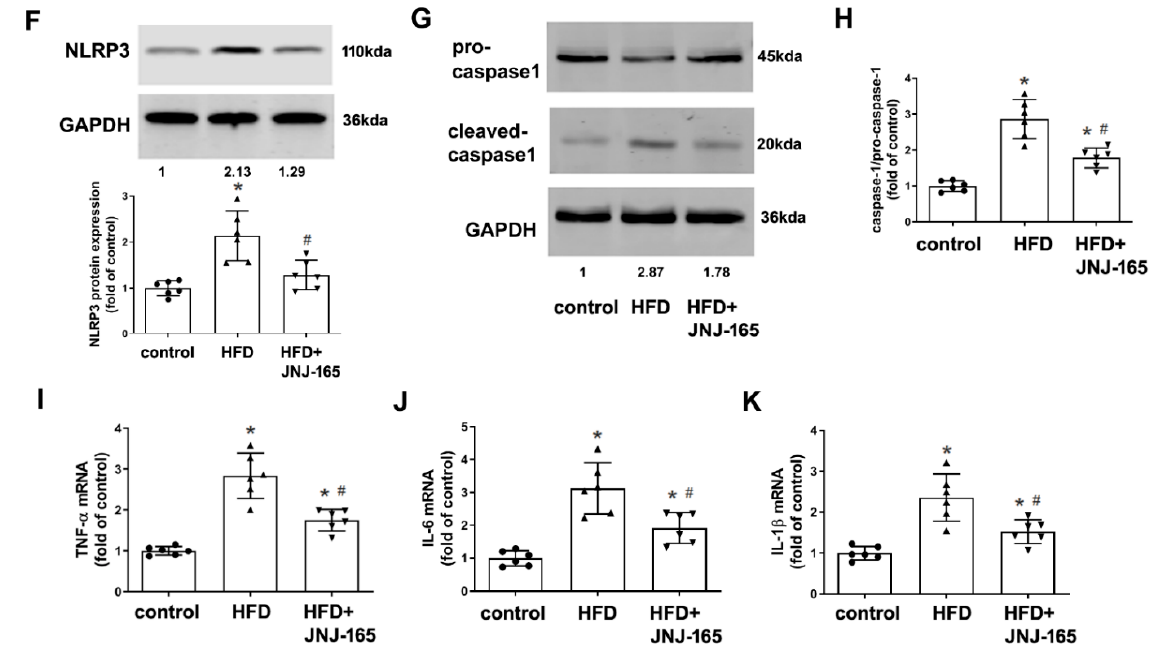
Figure 9. MDM2 inhibition alleviates mitochondrial damage and related inflammation in HFD-fed LDLr -/- mice. ( A , B ) Representative images and quantification of thoracic aorta cross-sections stained with mitoSOX Red. ( C ) The protein expression of PGC1 α . ( D ) The protein expression of TLR9. ( E ) NF- κ B p65 DNA binding activity. ( F ) The protein expression of NLRP3 in the aorta. ( G , H ) The protein expression of caspase-1. ( I – K ) mRNA expression of TNF- α ( I ), IL-6 ( J ) and IL-1 β ( K ) in the aorta. Results are presented as the mean ± SD. ( n = 6). * p < 0.05 vs. control group. # p < 0.05 vs. HFD group. The individual data points are shown as the circles, the normal or upside down triangles on top of the corresponding bars.